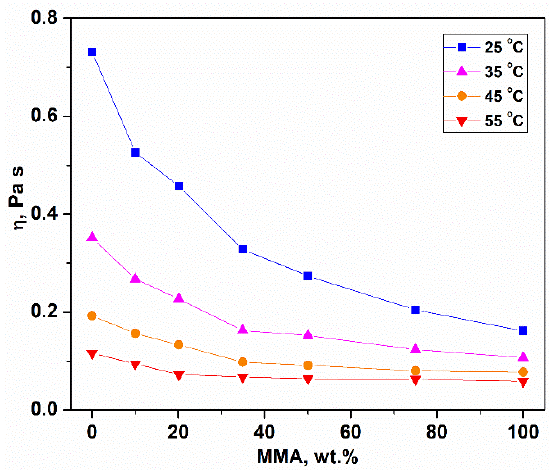
Figure 2. Viscosity as a function of temperature of the examined UP resins.